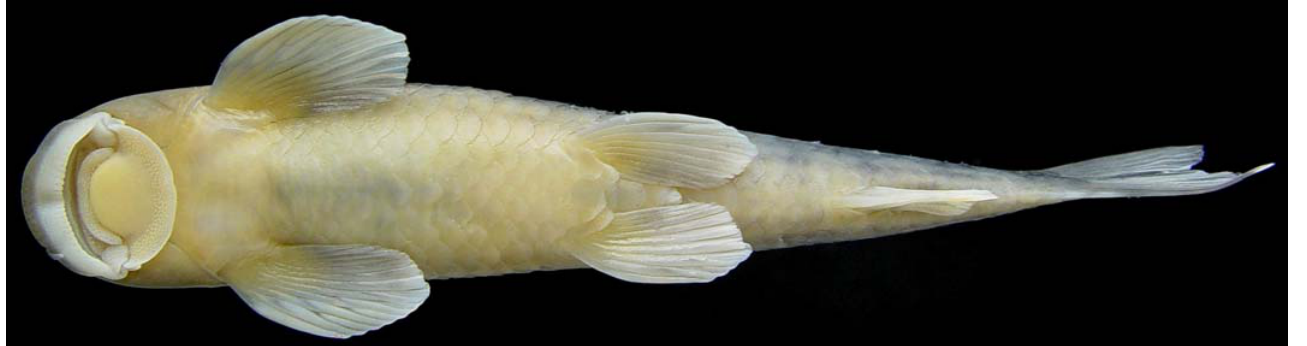
RGUMF-0184Image 2. Garra arupi sp. nov. Ventral view of holotype